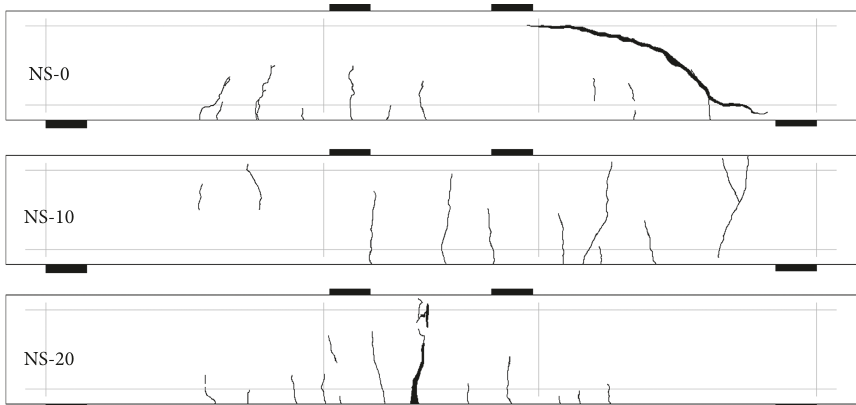
Figure 18: Crack patterns of NSC shear specimens.